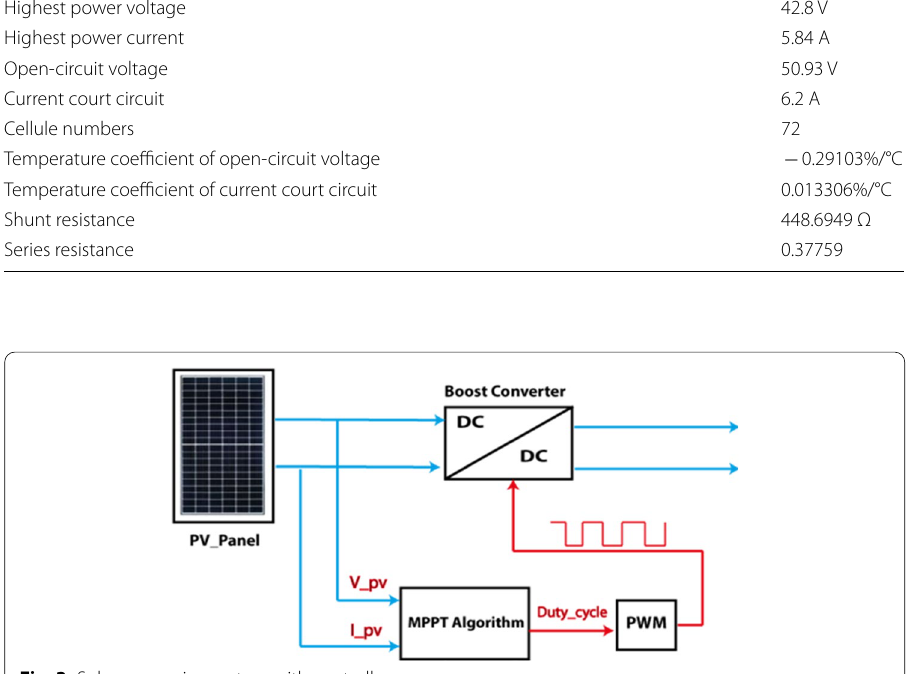
Fig. 3 Solar conversion system with